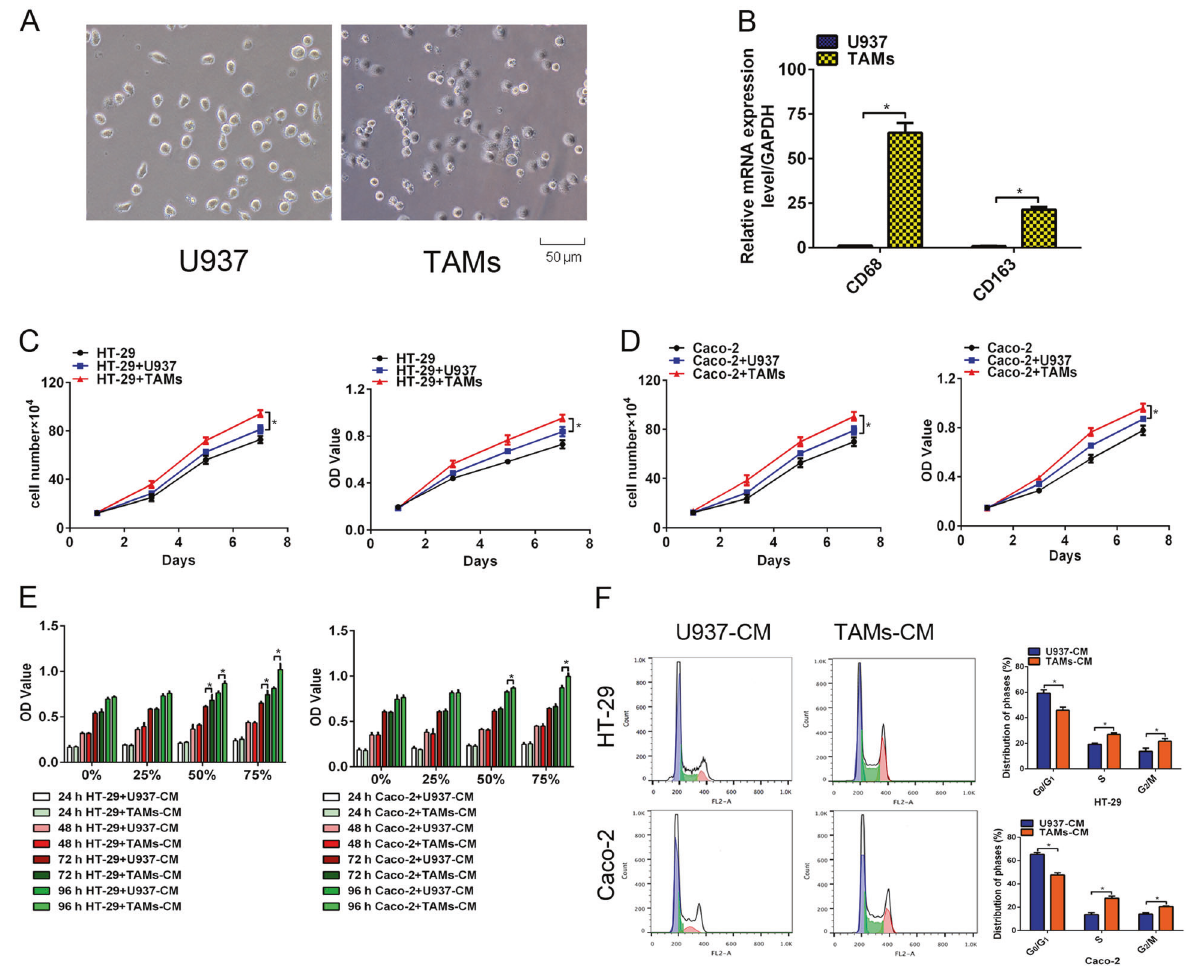
Fig. 1 TAMs enhanced the proliferation of colon cancer cells. A After incubation with PMA and IL-4, the smooth surface morphology of U937 cells had a thorny appearance because of pseudopodia, and the suspended cells became adherent. B Comparison of the mRNA levels of CD68 and CD163 between U937 cells and TAMs by RT-PCR. C , D Cell growth and cell viability assays showed that co-culture with TAMs facilitated the growth and viability of HT-29 ( C ) and Caco-2 ( D ) cells in relation to the co-culture with U937 cells. E HT-29 and Caco-2 cells were cultured with 0, 25, 50, and 75% TAMs-CM or U937-CM for different time. Treatment with 50 or 75% TAMs-CM for 72 or 96 h promoted HT-29 and Caco-2 cells viability. F FACS analysis of cell cycle distribution indicated that treatment with TAMs-CM accelerated cell cycle transition from G0/G1 to S and G2/M phase. All data are presented as the mean ± SD from three independent experiments. * P <